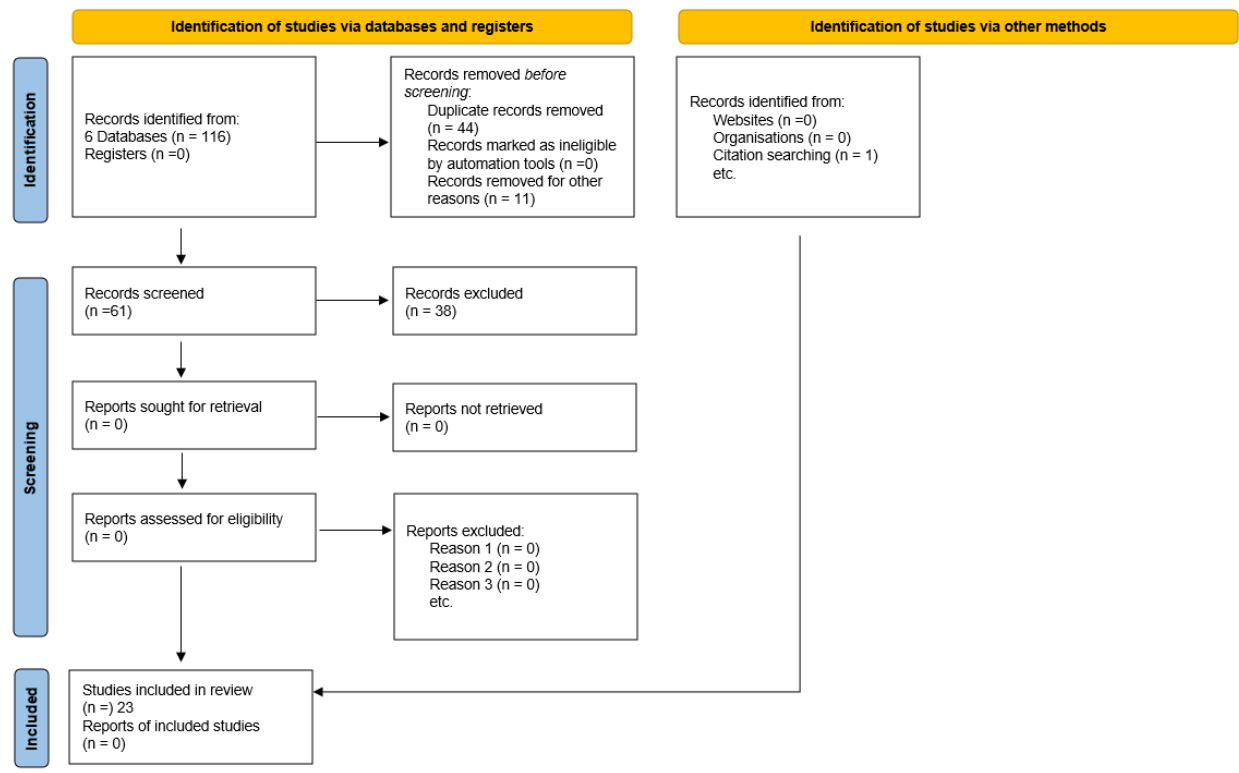
Figure 1. PRISMA flow diagram for literature search.